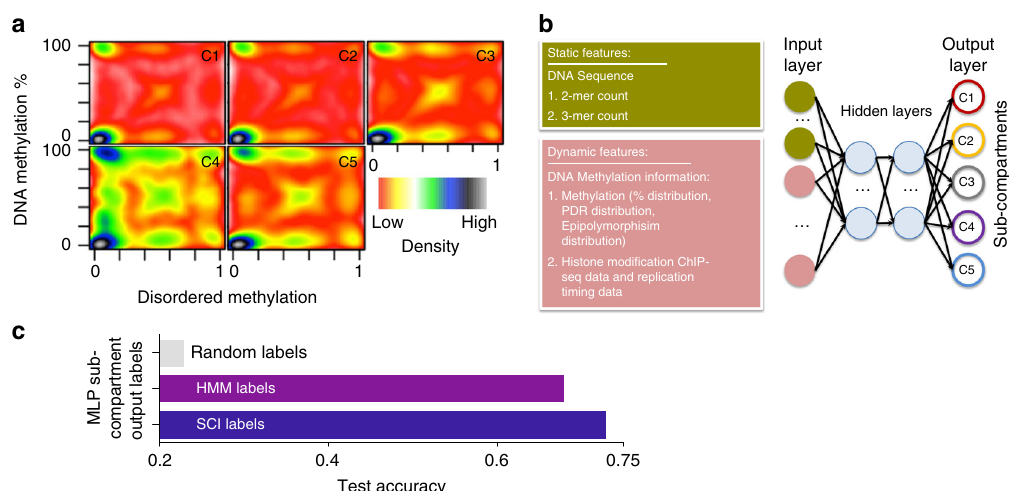
Fig. 5 Deep neural network predicting sub-compartments using DNA methylation. a Smoothed scatter plot showing the distribution of the percentage of DNA methylation and the proportion of disordered DNA methylation reads for all sub-compartments. b The schematic diagram for the constructed a deep neural network (DNN) model to predict sub-compartments from methylation and DNA sequence features. c Bar plot showing the accuracy of sub- compartment prediction using random classi fi er trained with random labels, HMM sub-compartment annotation, or SCI sub-compartment